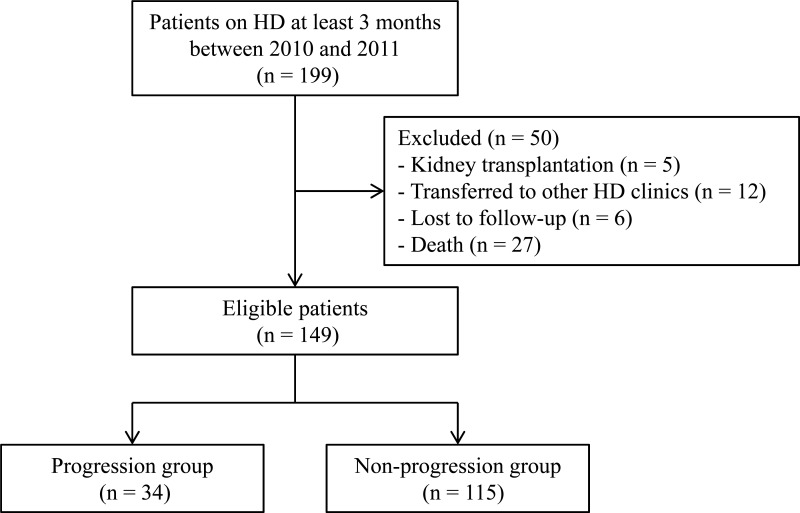
Study flow diagram.